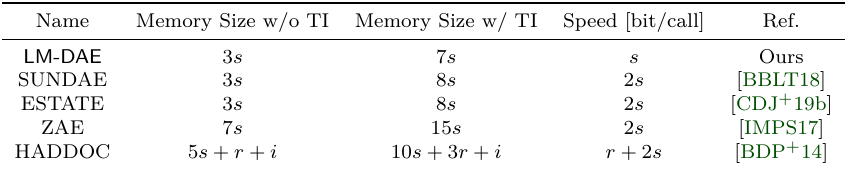
Table 2: Memory size with and without TI, and speed, when the security levels are fixed to s . We set the parameters to k = t = n = s for TBC-based DAEs; k = s and n = 2 s for BC-based DAEs; k = s , c = 2 s and τ = 2 s